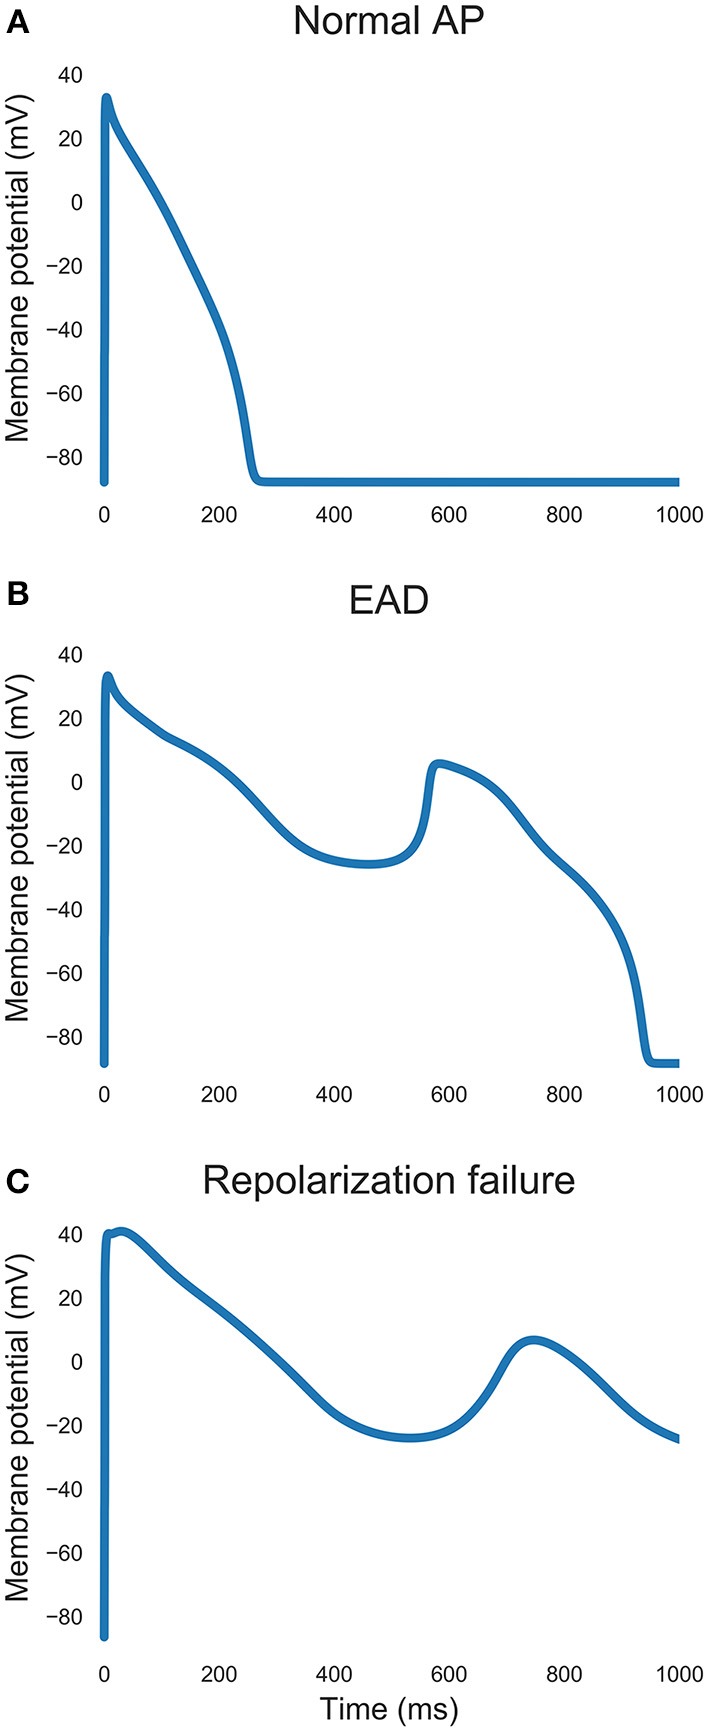
Examples of action potential traces. (A) Normal repolarization. (B) An early afterdepolarization. (C) Repolarization failure.